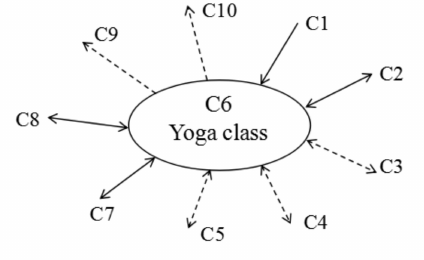
Figure 2. Simplified NRM.